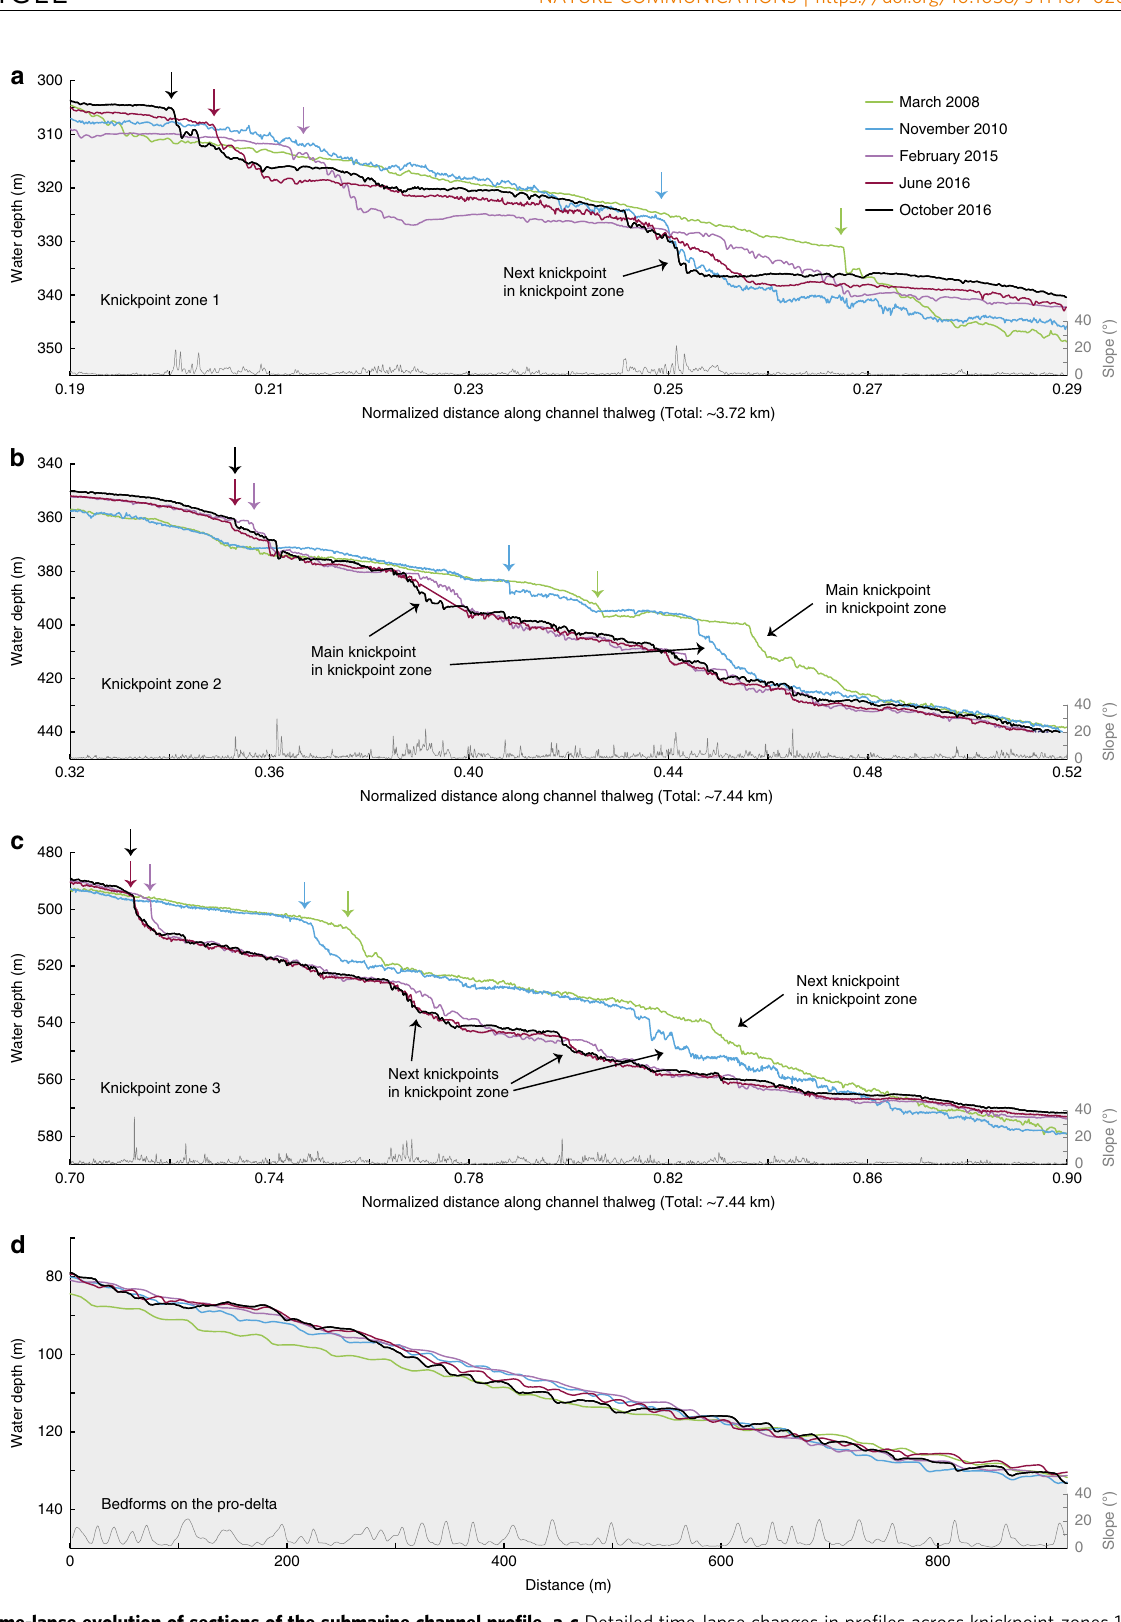
Fig. 4 Time-lapse evolution of sections of the submarine channel pro fi le. a - c Detailed time-lapse changes in pro fi les across knickpoint-zones 1, 2 and 3, whose locations are indicated in Fig. 3a. 20x vertical exaggeration. Slope was generated using the survey from October 2016.Arrows indicate the position of the frontal frontal-knickpoint in each survey. d Pro fi le along the shallow-water pro-delta channel, as indicated in Fig. 2a, where crescentic shape bedforms dominate and no knickpoints are present. 5x vertical exaggeration. Note the relatively small amount of bathymetric change, when compared to the three knickpoint